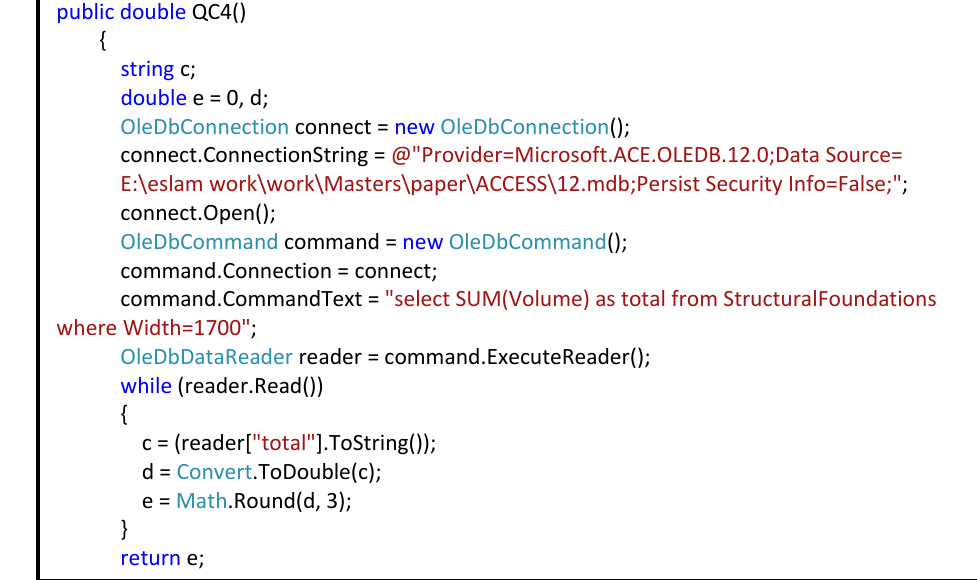
Fig. 2. Developed code to retrieve data from Microsoft Access